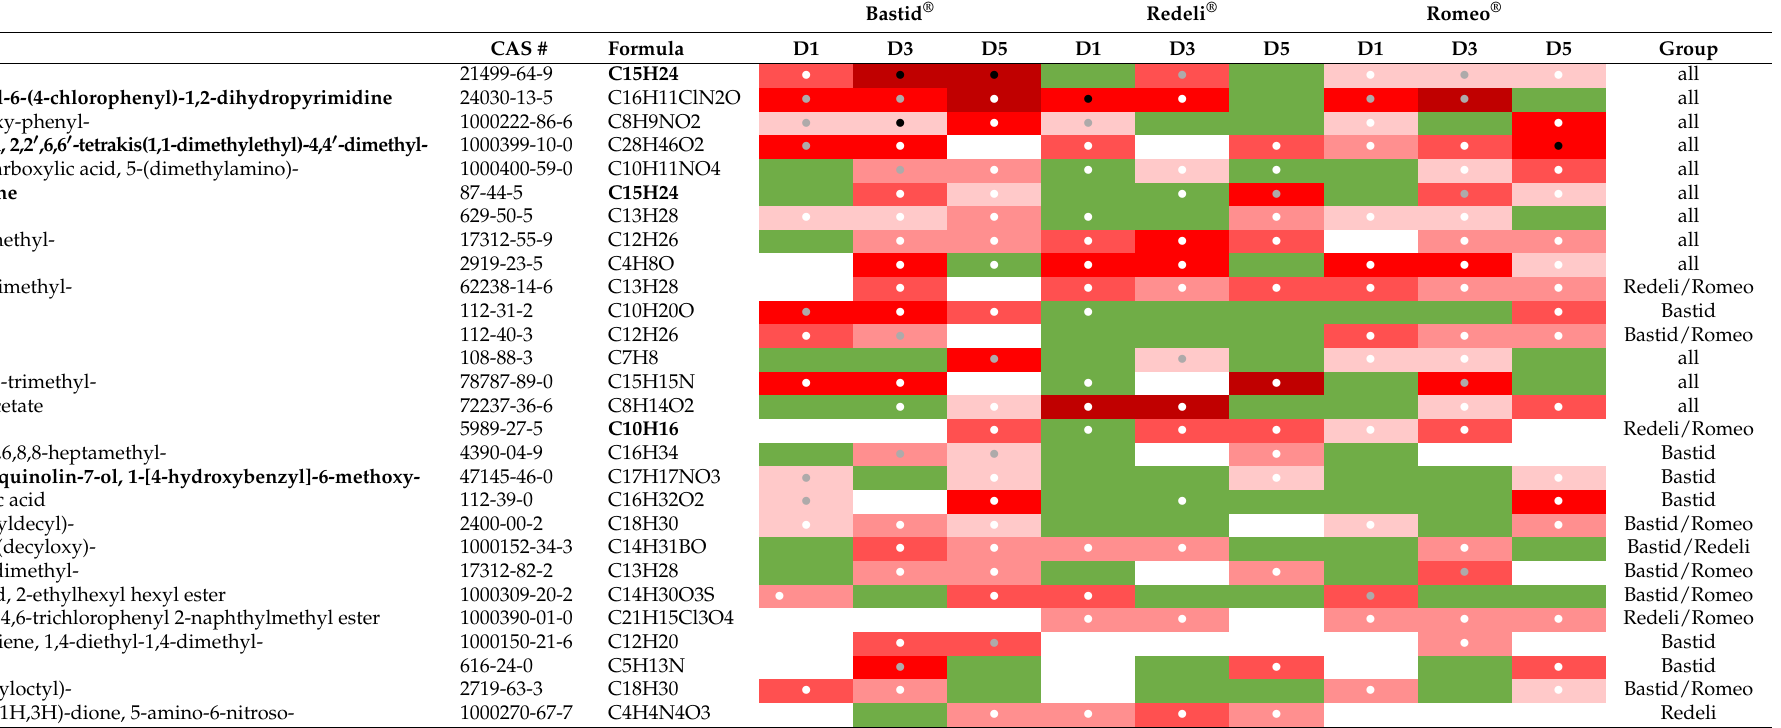
Table 2. VOCs induced by the commercial elicitors Bastid ® , Redeli ® , and Romeo ® . List of the VOCs induced (FC > 1.5 compared to the water control) at least twice by Bastid ® , Redeli ® or Romeo ® treatment (three replicates/treatment). Coloured boxes indicate average elicitor/H 2 O induction ratios 1, 3, and 5 days post treatment (D1, D3, and D5), with (cid:4) fold